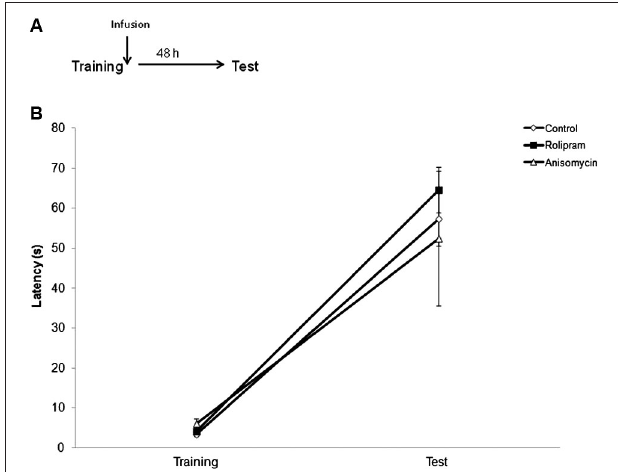
FIGURE 5 | Neither rolipram nor anisomycin affect IA memory formation when infused into the hippocampus immediately after training . Rats were given an IA training trial followed 48 h later by a test trial. An intrahippocampal infusion of vehicle ( N = 11), rolipram (7.5 µ g/side, N = 12) or anisomycin (80.0 µ g/side, N = 9) was given immediately after training. (A) Schematic diagram showing the experimental design. (B) Latencies to step-down during IA behavioral trials. There were no significant differences among